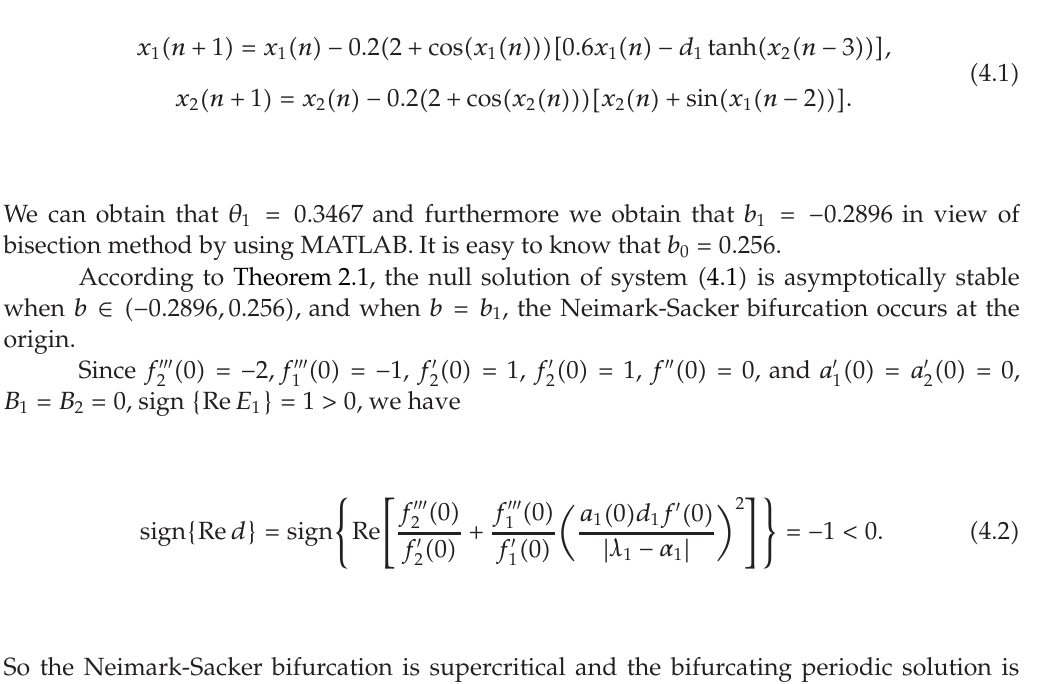
,x (cid:6) for system (cid:4) 4.1 (cid:6) with initial condition (cid:4) 0.6,0.6 (cid:6) and d 1 2